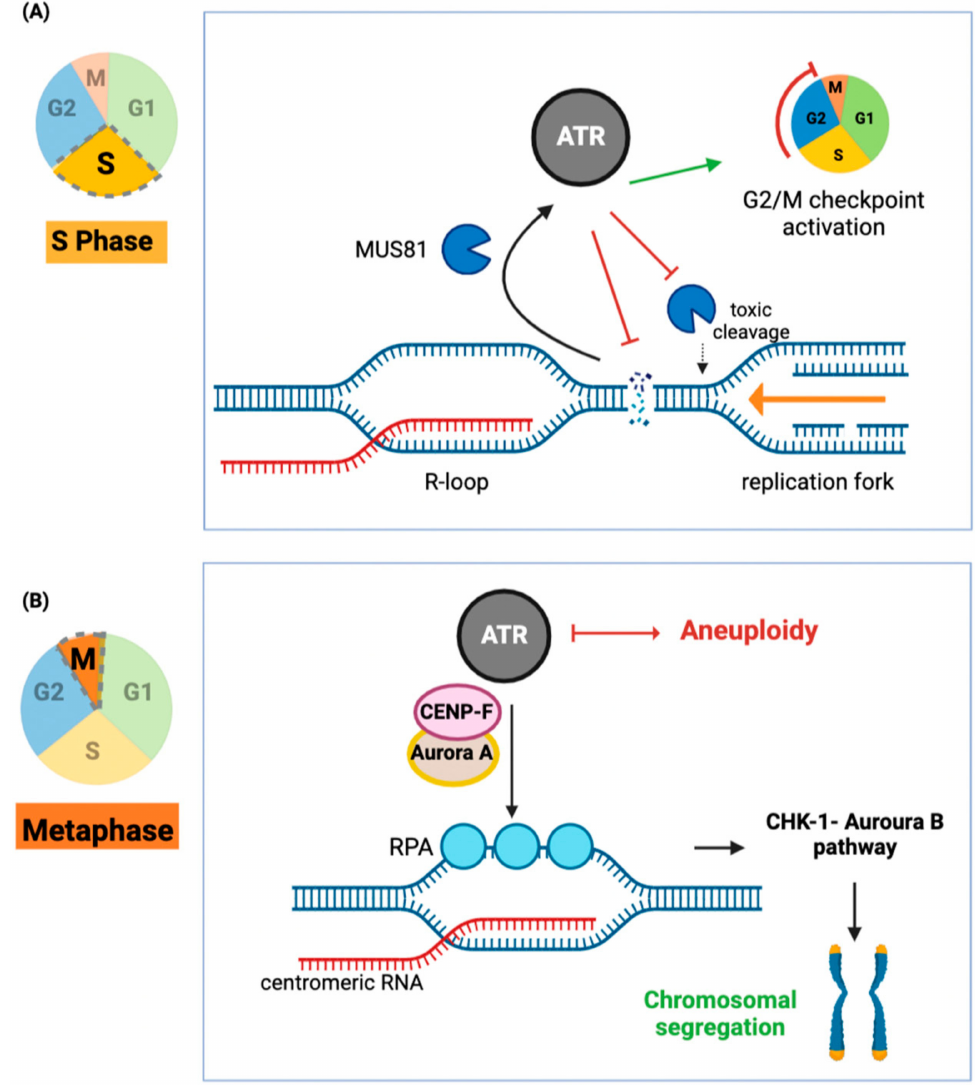
Figure 4. ATR protects the genome against DNA damage upon R-loop formation and ensures faithful chromosomal segregation. ( A ) During the S phase (DNA synthesis), unplanned R-loop formation signals the recruitment of ATR by the endonuclease MUS81 [77]. This activates a DNA damage response and G2/M cell cycle arrest, allowing time for fork recovery and preventing excessive double-strand break formation. ATR also signals a negative feedback response to MUS81 to prevent fork degradation mediated by MUS81’s endonuclease activity; ( B ) During cell division, ATR is recruited to centromeric R-loops, which are coated with replication protein A (RPA) by Aurora-A, a serine/threonine-protein kinase, and the microtubule-binding protein centromere protein F (CENP-F). This enables efficient chromosomal segregation through activation of Chk1-Auroura-B pathway. In consequence, inhibition of ATR results in improper chromosomal segregation and aneuploidy [79]. ATR (DNA damage sensor): Ataxia telangiectasia-related. Cell cycle: G1: growth phase 1; S: DNA synthesis phase; G2: growth phase 2; M: